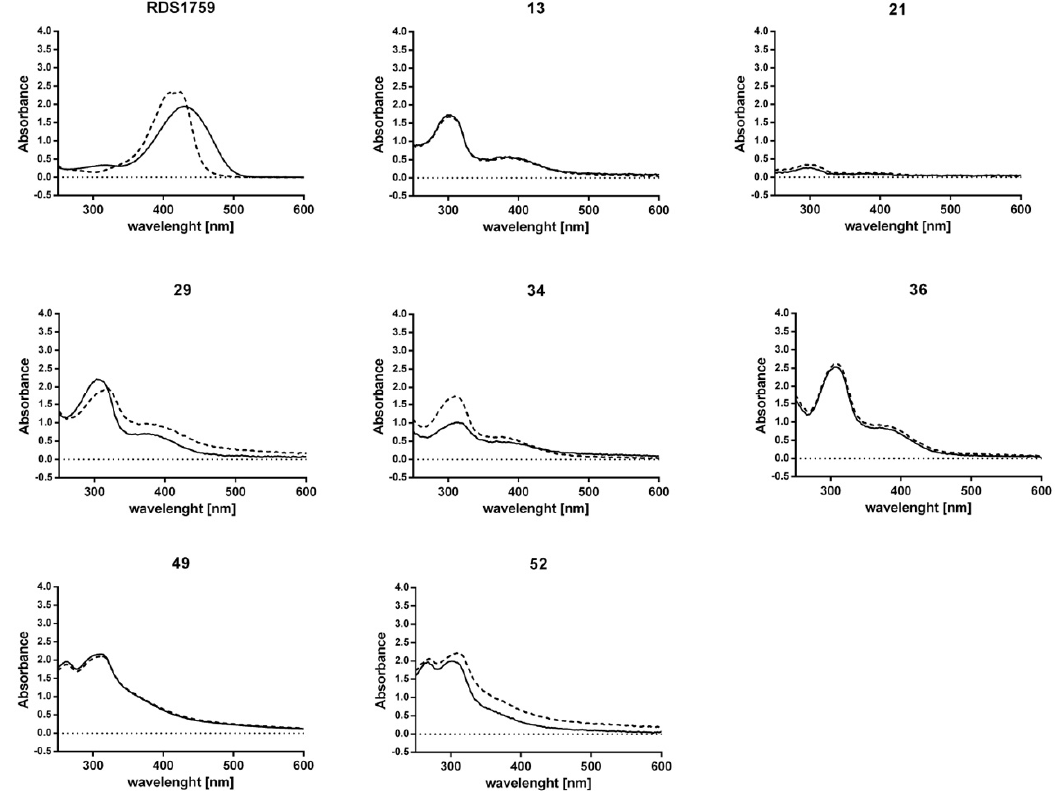
Figure 2. E ff ect of MgCl 2 on the absorbance spectra of 2-(arylamino)-6-(trifluoromethyl)nicotinic acid derivatives. Mg 2 + chelation UV-Vis spectrum was measured with 100 µ M of compound alone (unbroken line) or in the presence of 6 mM MgCl 2 (dotted line). The active site RNase H inhibitor RDS1759 was used as reference.